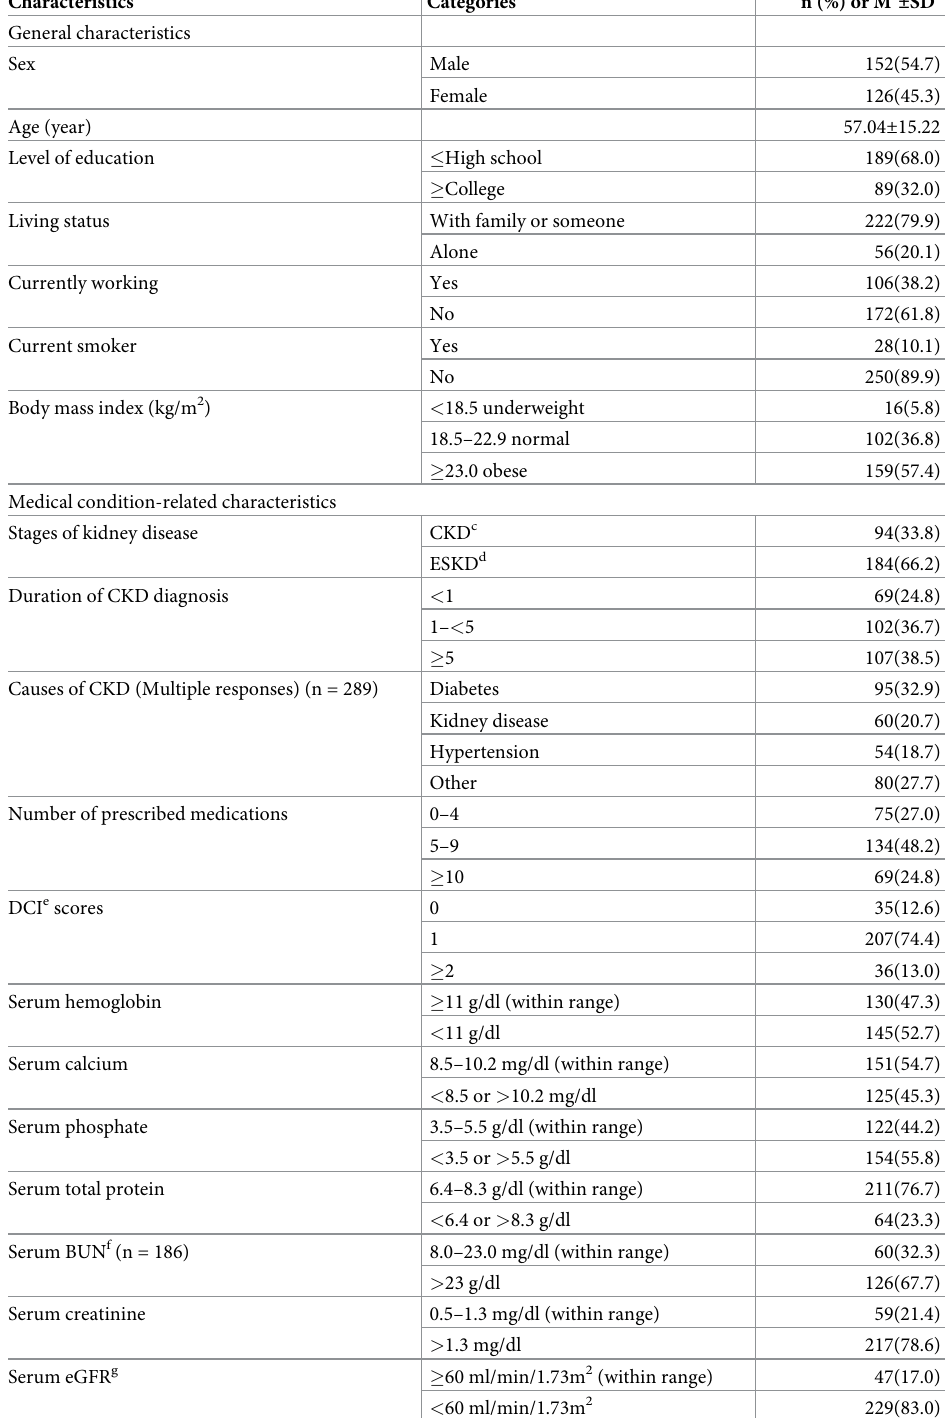
Table 1. Participants’ characteristics (N =